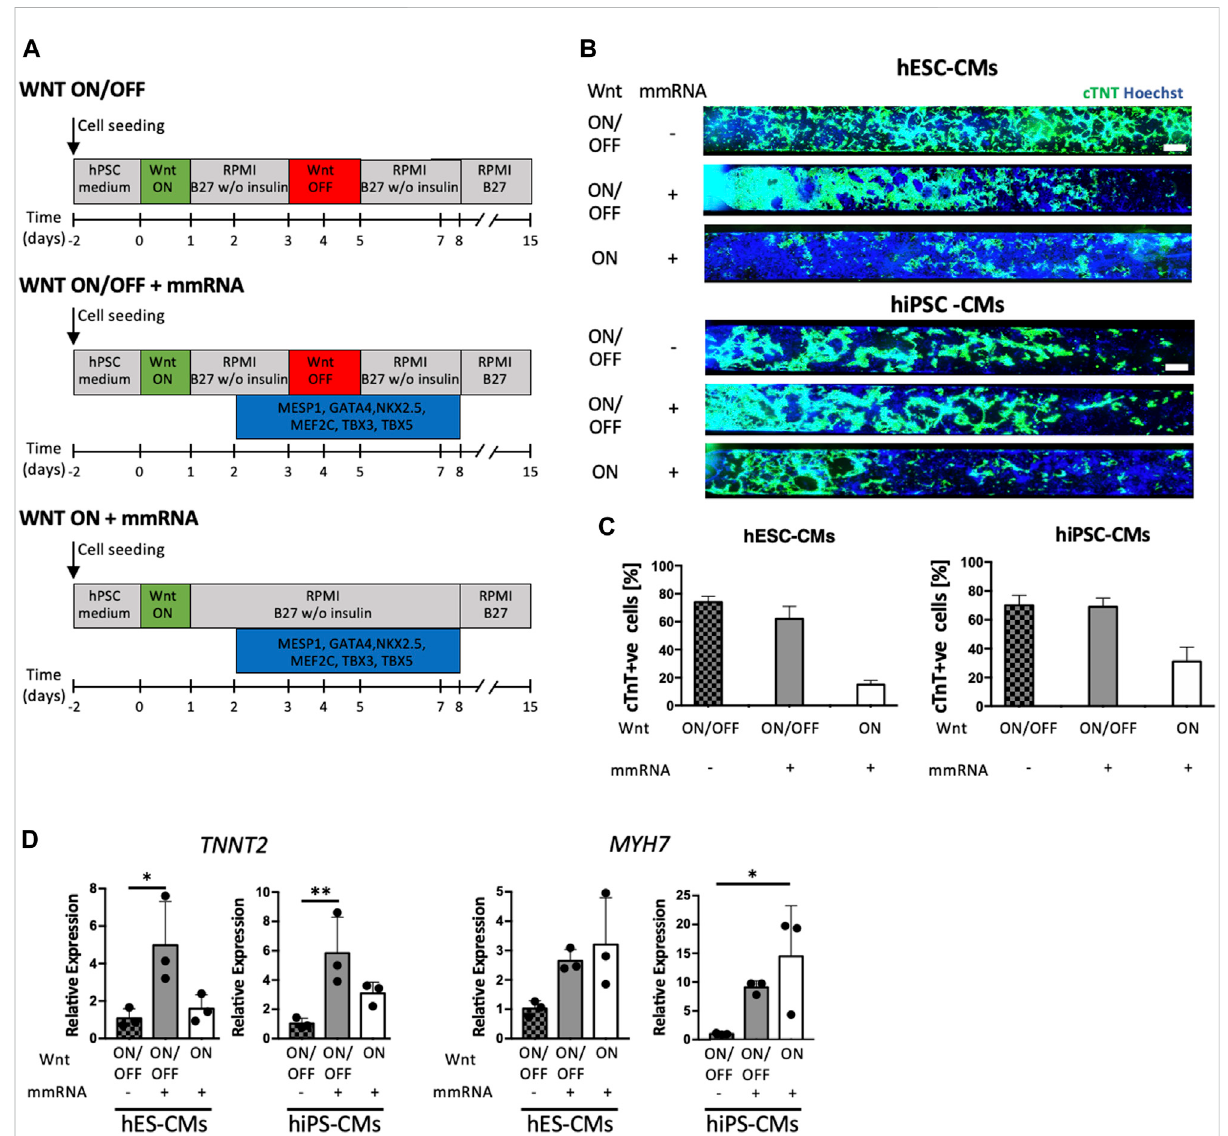
FIGURE 3 hPSC cardiac differentiation on-chip mediated by Wnt signal and cardiac mRNA expression. (A) Schematic representation of the three experimental strategies applied in parallel. Top, standard protocol (Lian X, 2012) for cardiac differentiation with small molecules modulating Wnt/ β - catenin pathway, CHIR99021 and IWP4, are used. Middle, strategy WNT ON/OFF + mmRNA in which the complete Wnt/ β -catenin pathway perturbation with CHIR99021 and IWP4 was coupled to cardiac mmRNA transfections for 6 days. Bottom, strategy WNT ON + mmRNA which only CHIR99021 was administered, in combination with mmRNA transfections for 6 days. Medium change was performed every 12 h. (B) Immuno fl uorescence staining for cTNT (green) in CMs obtained from hESCs (upper panel) and hiPSCs (lower panel) differentiated in micro fl uidic platform,inthethreeprotocolsimplemented.NucleiwerecounterstainedwithHoechst.Scalebars750 μ m. (C) Quanti fi cationofcTNTpositiveCMs fromhESCsandiPSCsinthethreeprotocolsimplemented. (D) Geneexpressionnormalizedto GAPDH of TNNT2 and MYH7 ,inCMs-mmRNAderived obtained from hESCs and hiPSCs at day 15 of cardiac differentiation. Data are shown as mean, error bars indicate SEM, n = 3. One-way ANOVA, p -value < 0.05 (*); p -value < 0.01